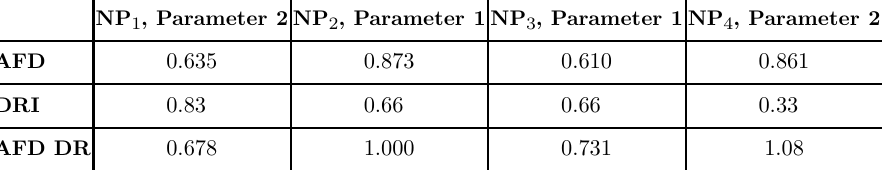
Noun phrases oculographic and Default Response